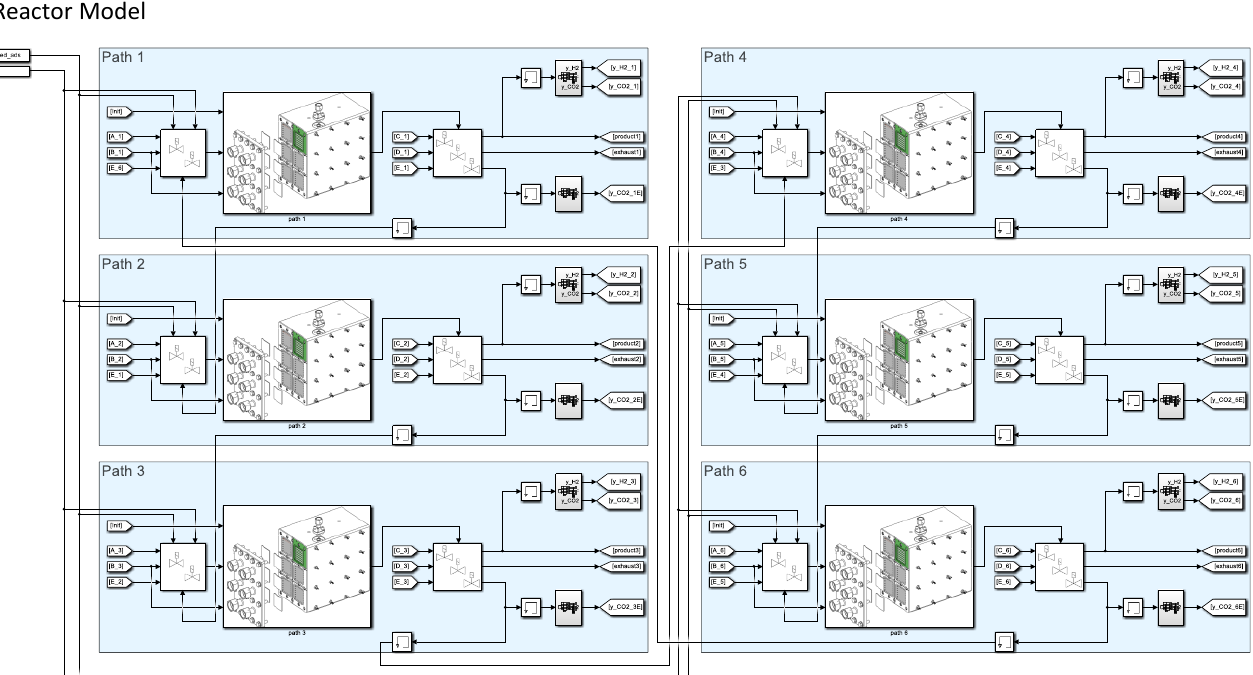
Figure 4. Simulink model consisting of six reaction chambers (blue), which are operated in either re- action or regeneration mode after an initialization step. Subsequent reaction chambers can optionally be connected. The cyclic process operation is controlled with a Stateflow machine